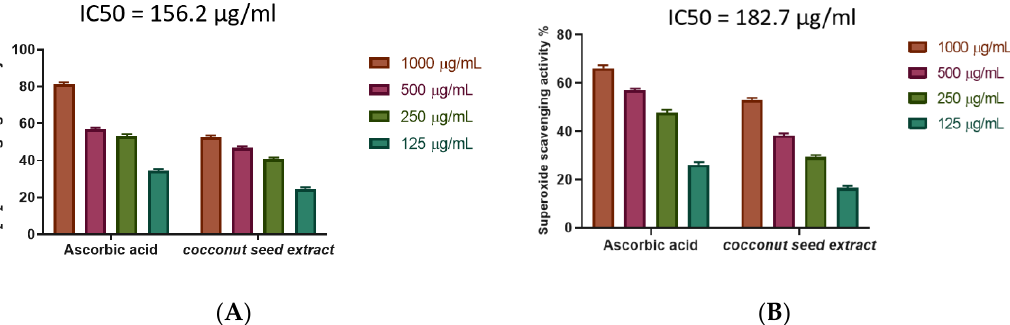
Figure 4. ( A ) Coconut seed extract potential of H 2 O 2 scavenging at different concentrations (1000 µg/mL, 500 µg/mL, 250 µg/mL, and 125 µg/mL). Bars represent mean ± standard deviation (SD). ( B ) Superoxide radical scavenging activity of coconut seed extract at different concentrations (1000 – 125 µg/mL). Bars represent mean ± SD. Significant difference between groups is analyzed by a two-way ANOVA test.